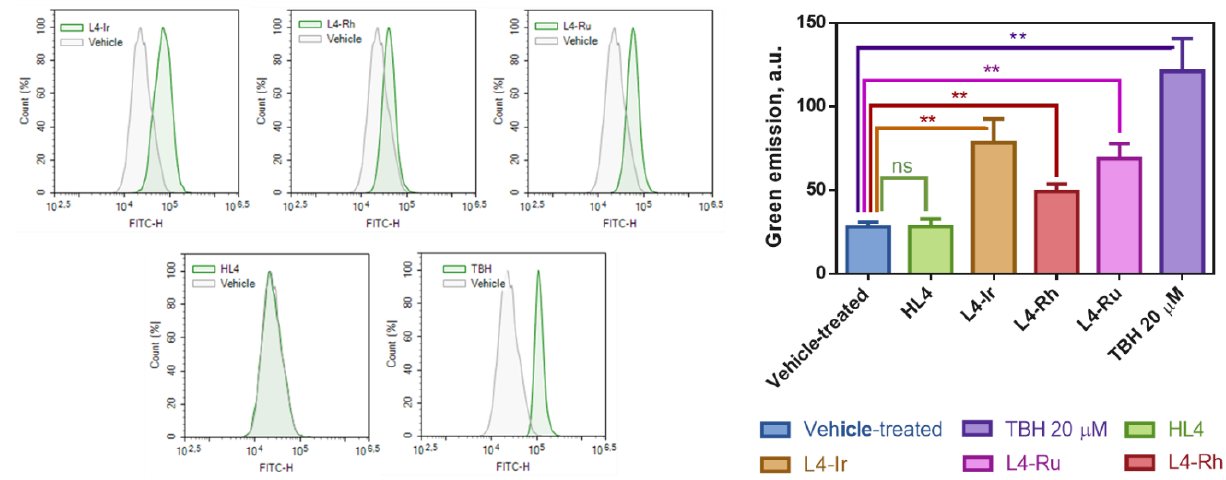
Figure 10. Flow cytometry plots of A549 cells treated with HL4 , L4-Ir , L4-Rh , L4-Ru at their IC 50 values during 24 h. Cells treated with 20 µM of TBH (tert-butyl-hydroperoxide) were included as positive control for H 2 O 2 generation. Results are expressed as the mean ± SD and statistical significance is expressed as **, p -value < 0.01 (ANOVA–Dunnett).